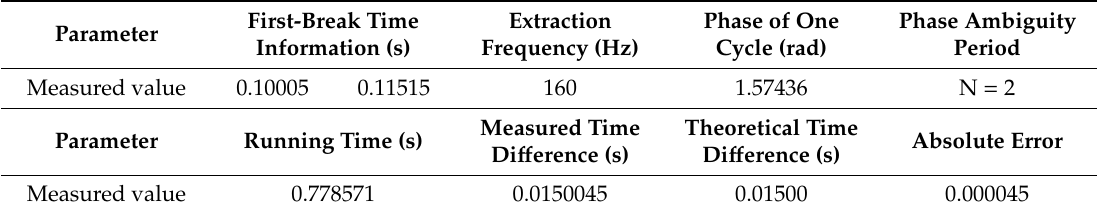
Table 2. Parameter values determined based on the phase difference information.